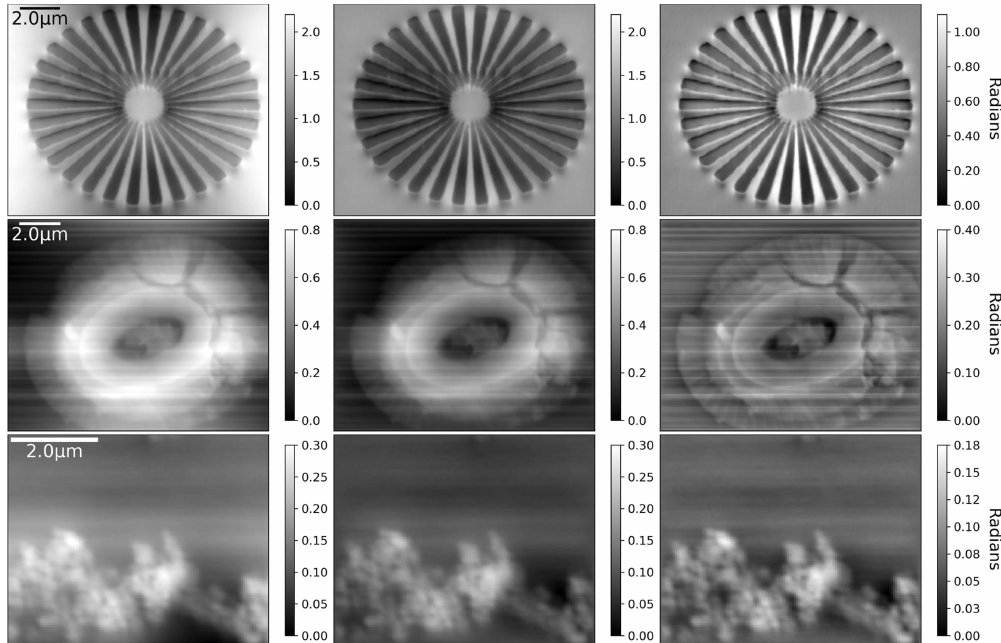
Figure 2 Left to right: DPC phase contrast image integrated using a mirror pattern, anti-symmetric pattern and high-pass filter ( (cid:6) = 0.0005 times the maximum k 2 value) for measurements of a (top) Siemens star, (middle) coccolith and (bottom) drop-cast Fe particles. The anti-symmetric mirroring improves the low- frequency background. As the high-pass filter removes the low-frequency contributions, the mirror and anti-symmetric patterns have no impact on the resulting image.